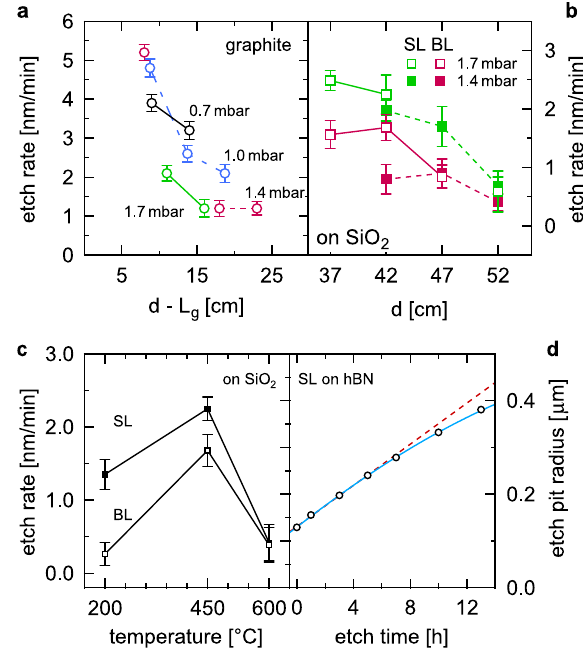
Fig. 4 Anisotropic etch rates. a Graphite anisotropic etch rate vs. distance from plasma d − L g for several con fi gurations. b Etch rate of SL and BL on SiO 2 at indicated parameters. c Temperature dependence of the etch rate of SL and BL samples on SiO 2 . Error bars are standard deviations. d Average radius of a circle inscribed to the hexagonal etch pits as a function of exposure time for SL on hBN. Several etch pits were evaluated in order to obtain average size and standard deviation, where the latter is smaller than the diameter of the marker circle. The dashed red line is a linear fi t to the points at ≤ 5 h, the blue curve is a tanh- fi t shown as a guide for the